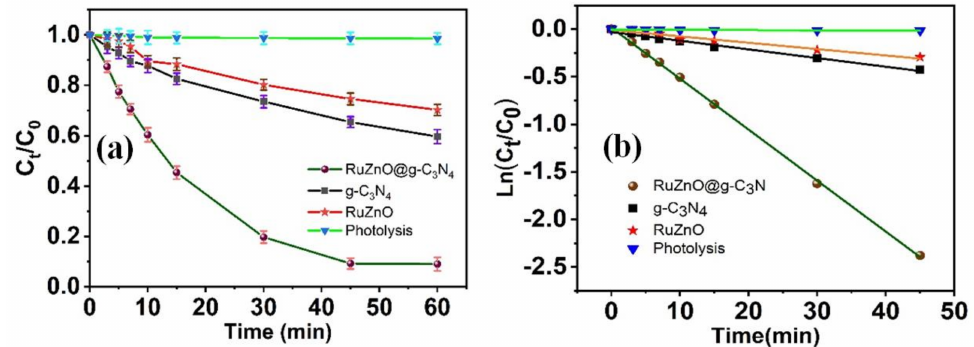
Figure 8. ( a ) The difference of photodegradation with time, and ( b ) pseudo-first-order kinetics of the methylene blue